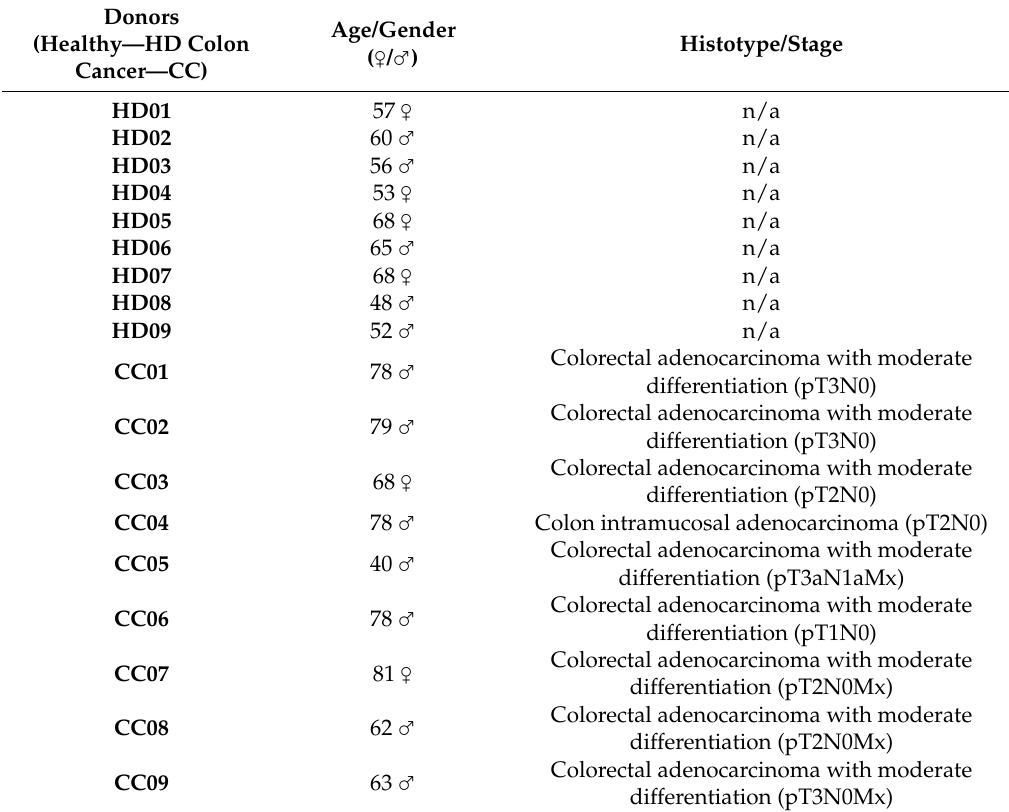
Table 1. CRC patient and healthy donors’